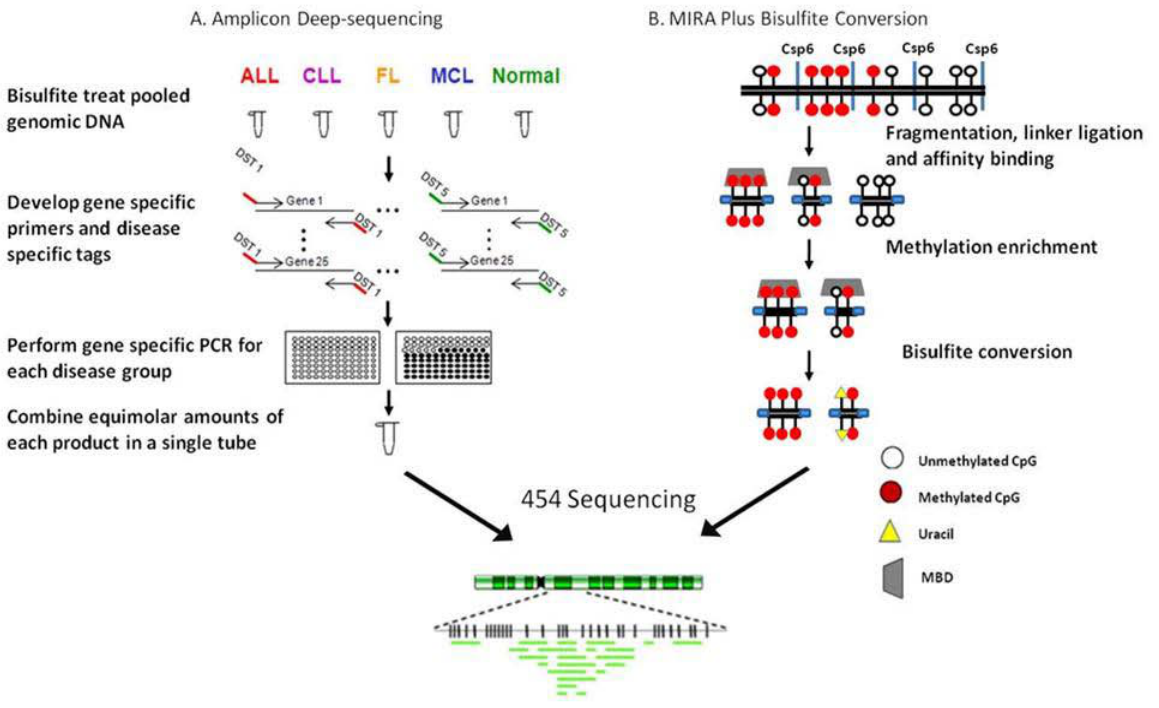
Figure 4. NGS approaches used to study lymphoid malignancies. A. Amplicon deep- sequencing. ALL: acute lymphoblastic leukemia; CLL: chronic lymphocytic leukemia; FL: follicular lymphoma; MCL: mantle cell lymphoma; DST: disease specific tag. B. MIRA plus bisulfite